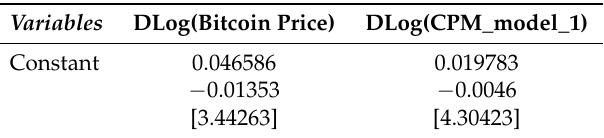
Table A1. VAR(0) for the Log-returns of the pair: Log(Bitcoin price), Log(CPM model 1). First sample: 01/08/2016–04/12/2017.